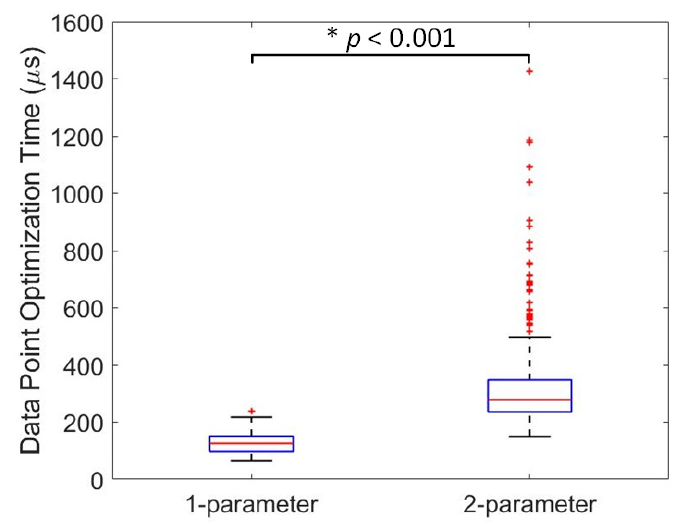
Figure 7. Data point optimization times vary with a statistically-significant difference with respect to the number of optimization parameters of each muscle activation